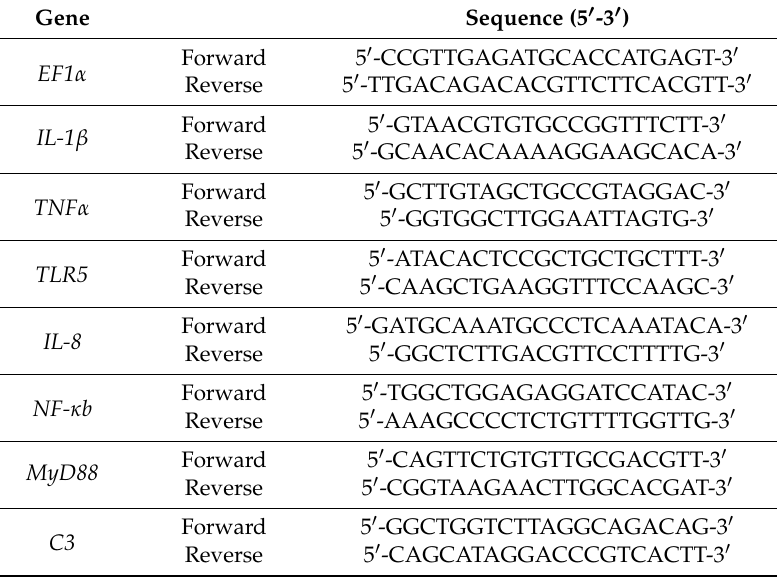
Table 5. Primer name and sequence used in the present